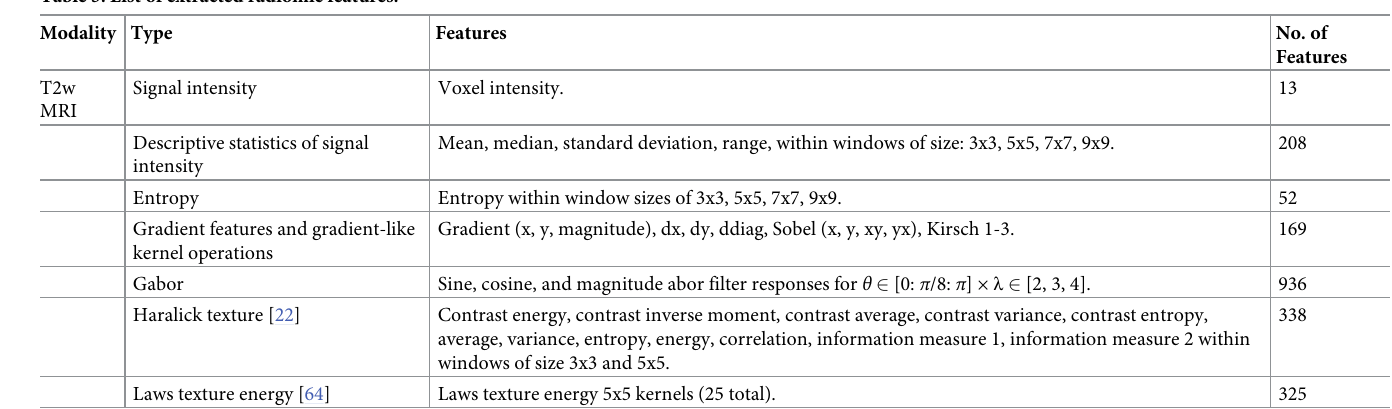
Table 3. List of extracted radiomic